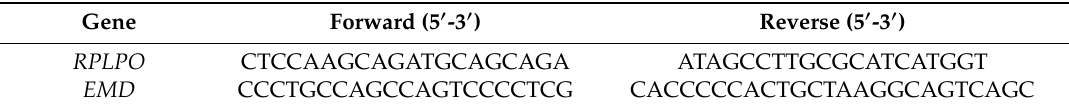
Table 2. List of qRT-PCR primers used in this